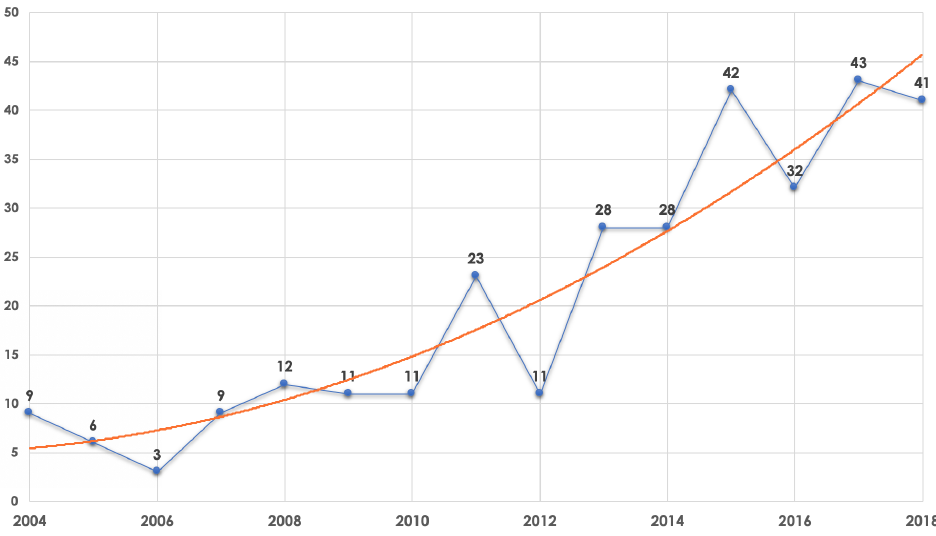
Figure 1. Number of papers including the word “Techno-regulation” on Google